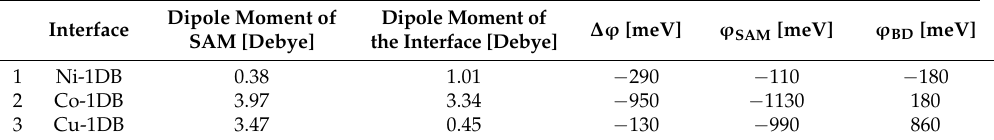
Table 1. Dipole moment, work function shift, molecular and bond dipole contributions of ∆ ϕ and charge transfer value for M-1DB